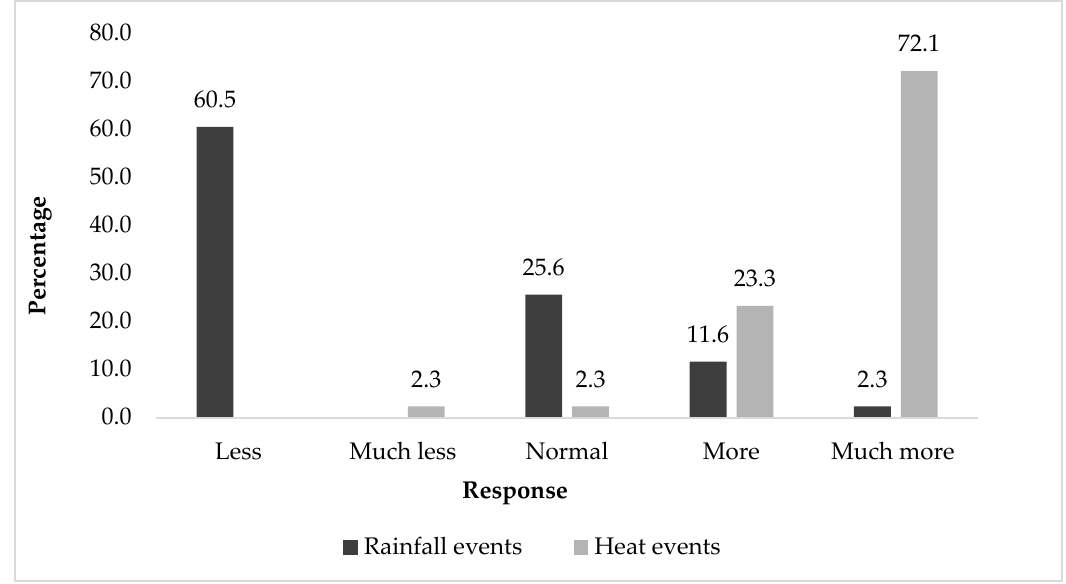
Figure 10. Perception of rain and heat behavior.